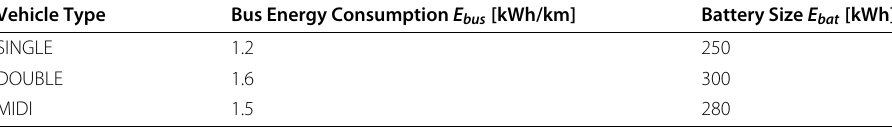
Table 4 Vehicle Types and their Parameters, adapted from (Jahic et al.